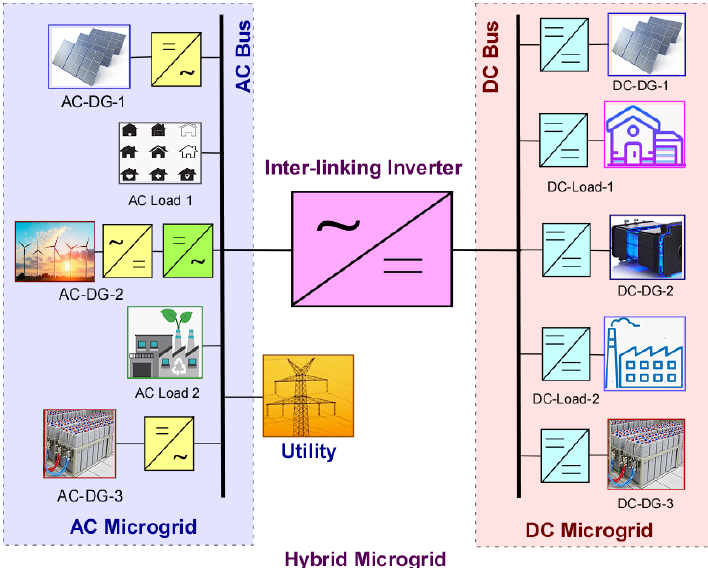
Figure 2. Layouts of hybrid